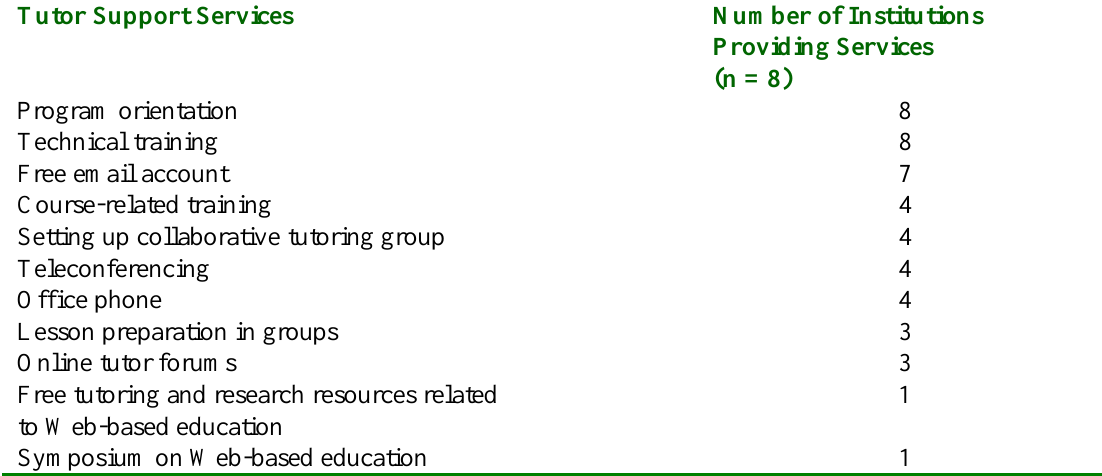
Table 18. Tutor support services provided by online institutions Tutor Support